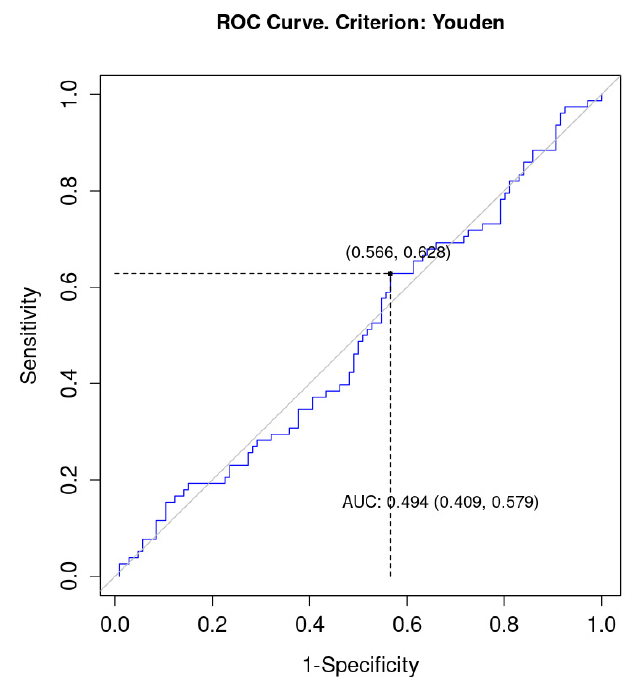
Figure 4. ROC (Receiver Operating Characteristic) curve for LMR as a discriminator of EMVI. AUC, area under curve.